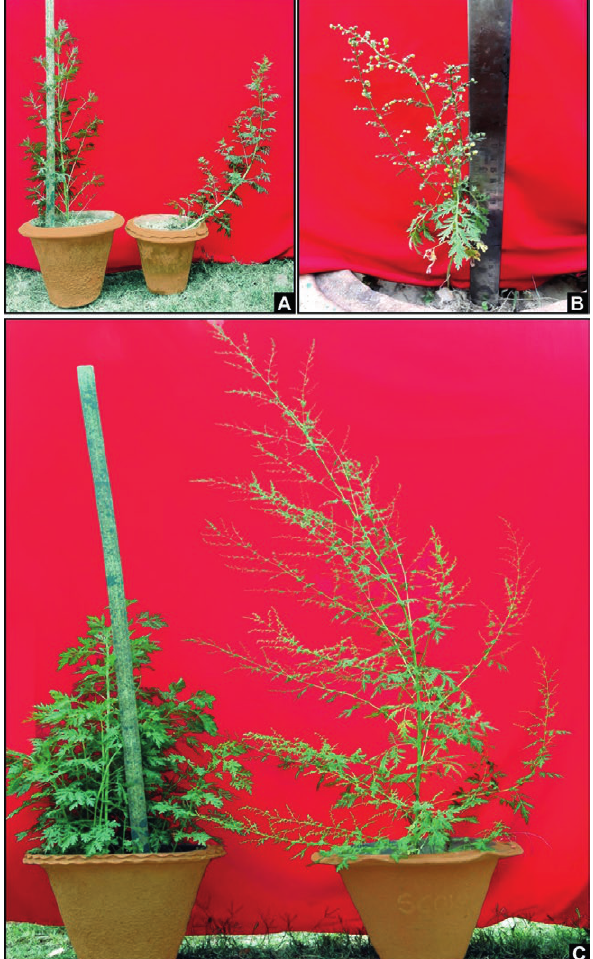
Figure 7. Some phenotypic variants in Artemisia annua L. A -Pros- trate variant, B - Dwarf variant C- Tall